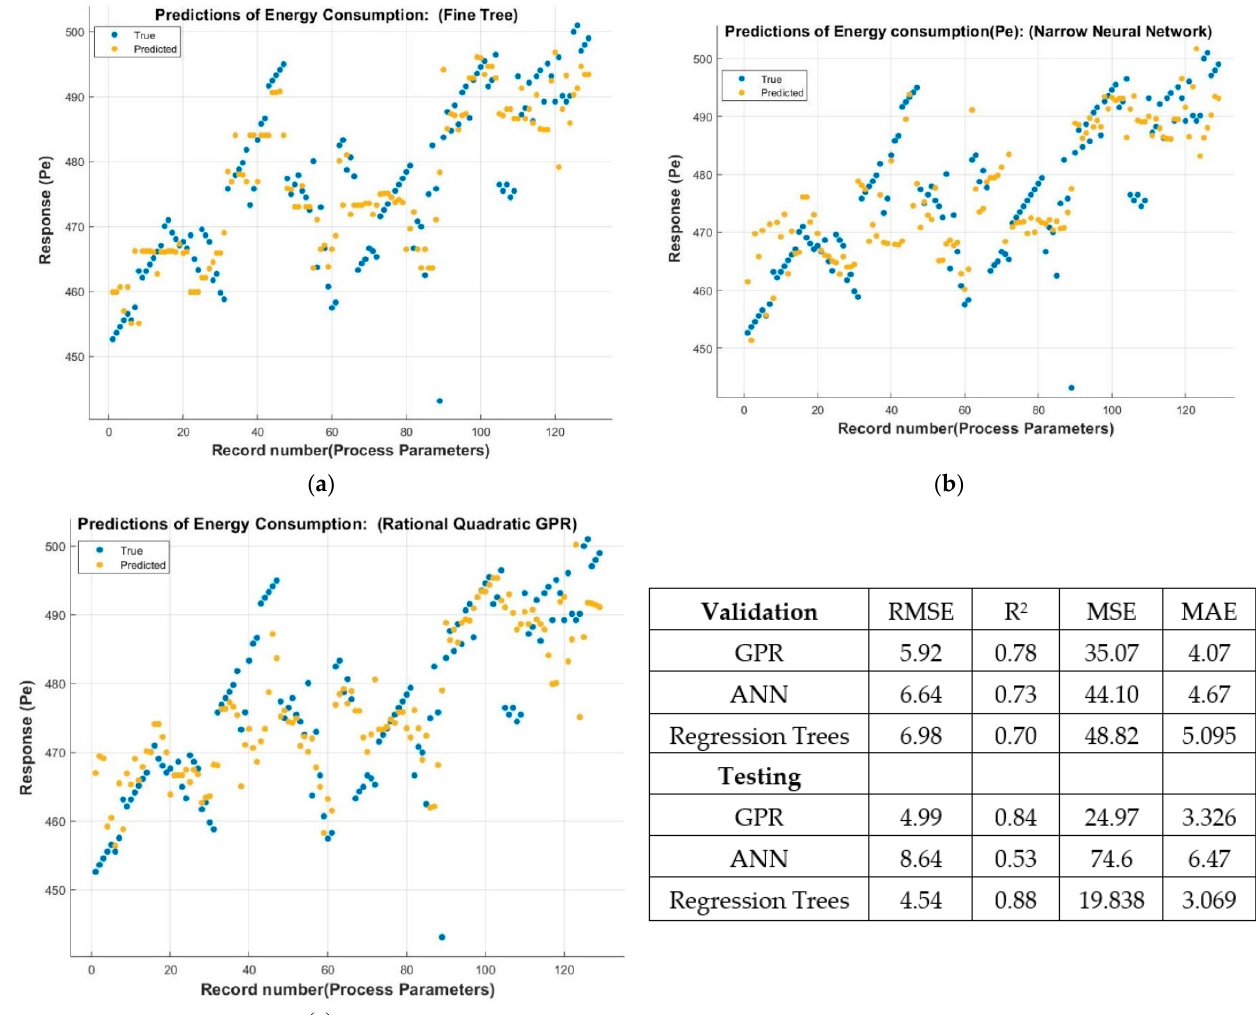
Figure 8. Predicted response of energy consumption ( E e ) with ( a ) regression trees, ( b ) Gaussian process regression, ( c ) ANN.